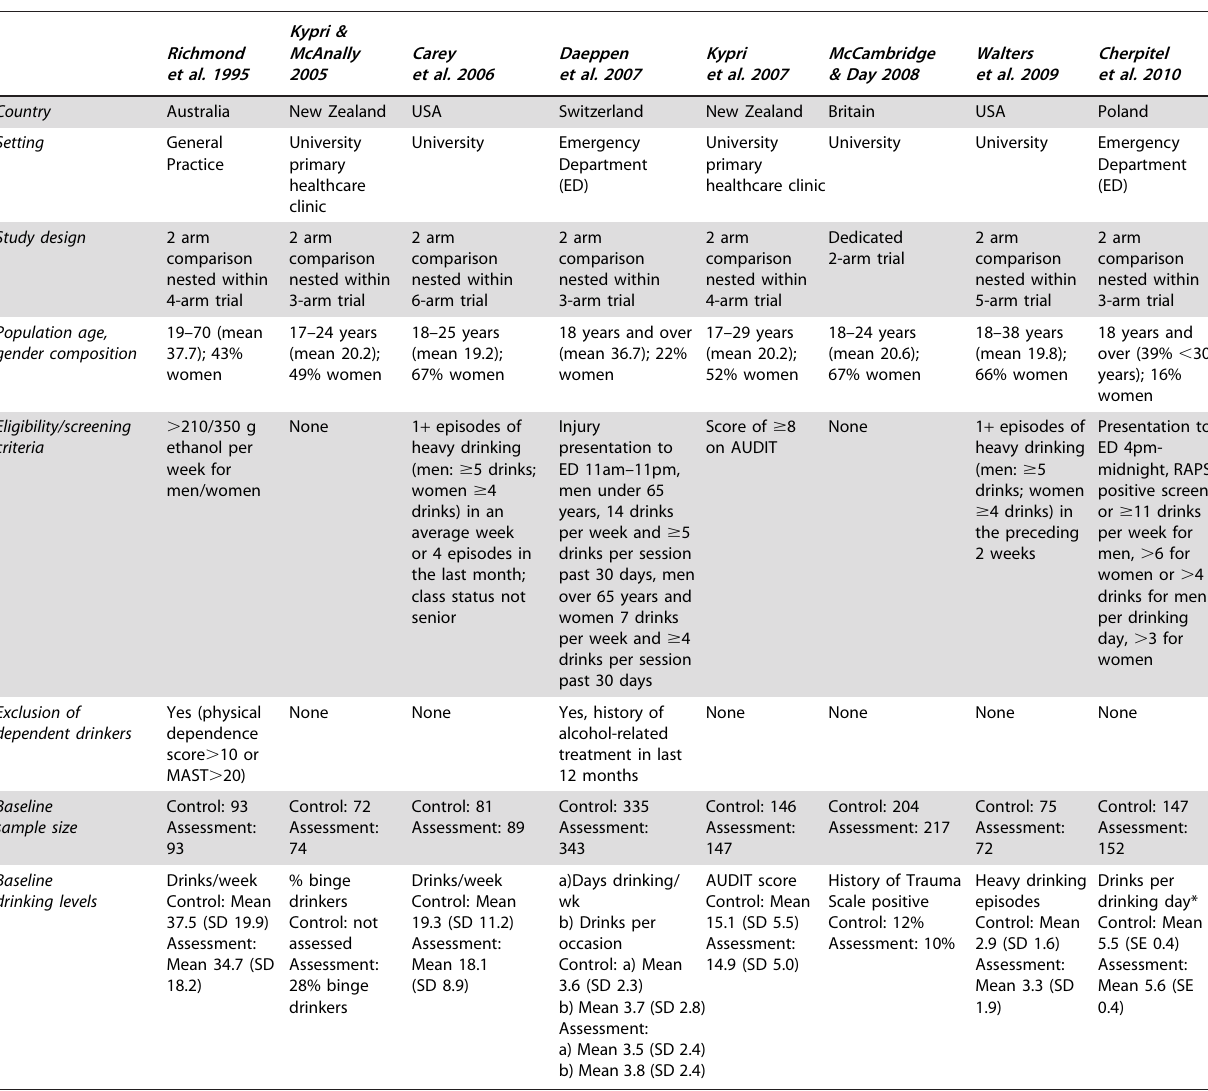
Table 1. Characteristics of studies included in